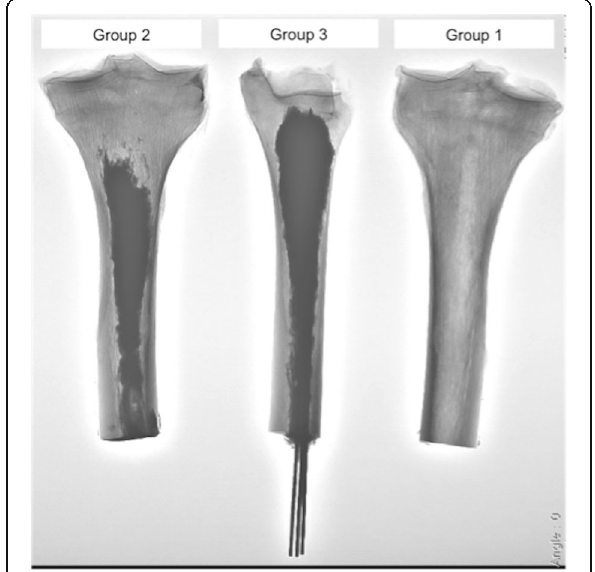
Fig. 1 Fluoroscopic image illustrating a bone sample from each experimental